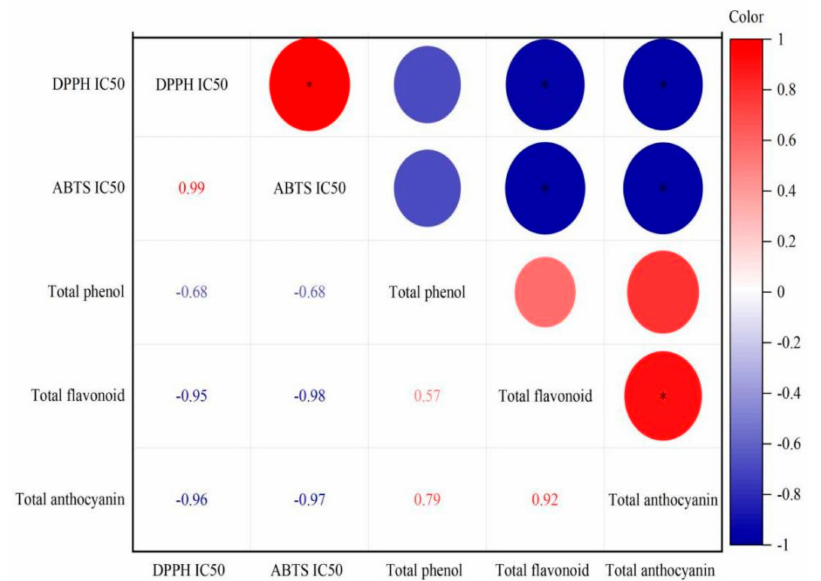
Figure 3. Correlation between total phenol, total flavonoid, total anthocyanin contents and antioxi- dant activities. The * indicated significantly different ( p < 0.05). The number represented the Pearson correlation